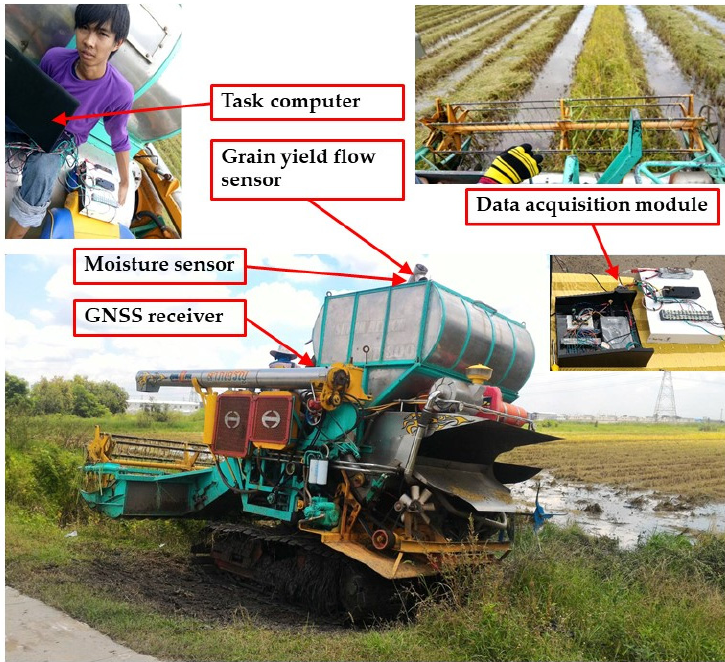
Figure 1. Yield meter